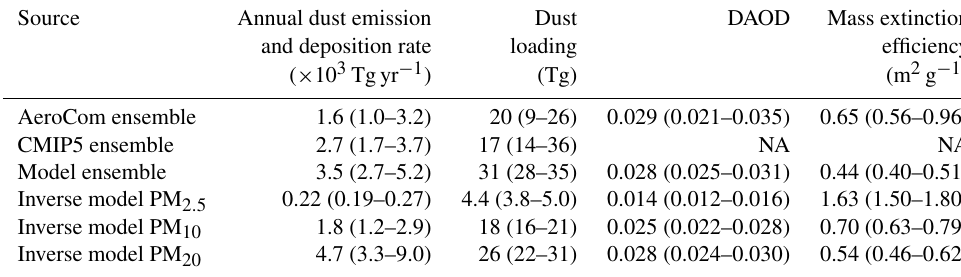
Table 3. Globally integrated annual dust emission rate, loading, DAOD, and mass extinction efficiency. Listed are median values, with 1 standard error ranges listed in parentheses. Also shown are AeroCom Phase I results, which were taken from Table 3 in Huneeus et al. (2011), and the 1 standard error range was obtained by eliminating the two highest and lowest values. This leaves the 10 central values of the 14 model results, which corresponds to the central 71% of model results. The CMIP5 results for the global dust emission rate and loading were obtained from the analysis of CMIP5 models with prognostic dust cycles by Wu et al. (2020; see their Table 3), who did not analyze DAOD and mass extinction efficiency. For the CMIP5 ensemble we similarly eliminated the four extreme values, leaving the 11 central values of the 15 model results, which corresponds to the central 73% of model results. For our own model ensemble, we eliminated the two extreme values, leaving the four central values of the six model results, which corresponds to the central 67% of model results. Inverse model results are listed for both PM 10 and PM 20 dust, whereas the size range accounted for by AeroCom and CMIP5 models differs for each model (see Huneeus et al., 2011; Wu et al., 2020, and Fig. S7). DAOD and MEE were taken at